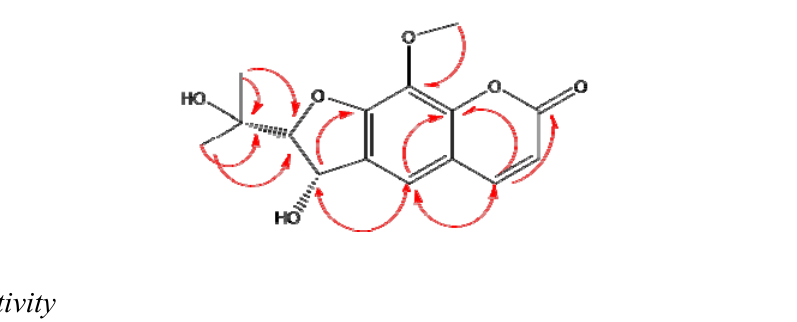
Figure 3. The structure of 8-methoxysmyrindiol supported by the HMBC